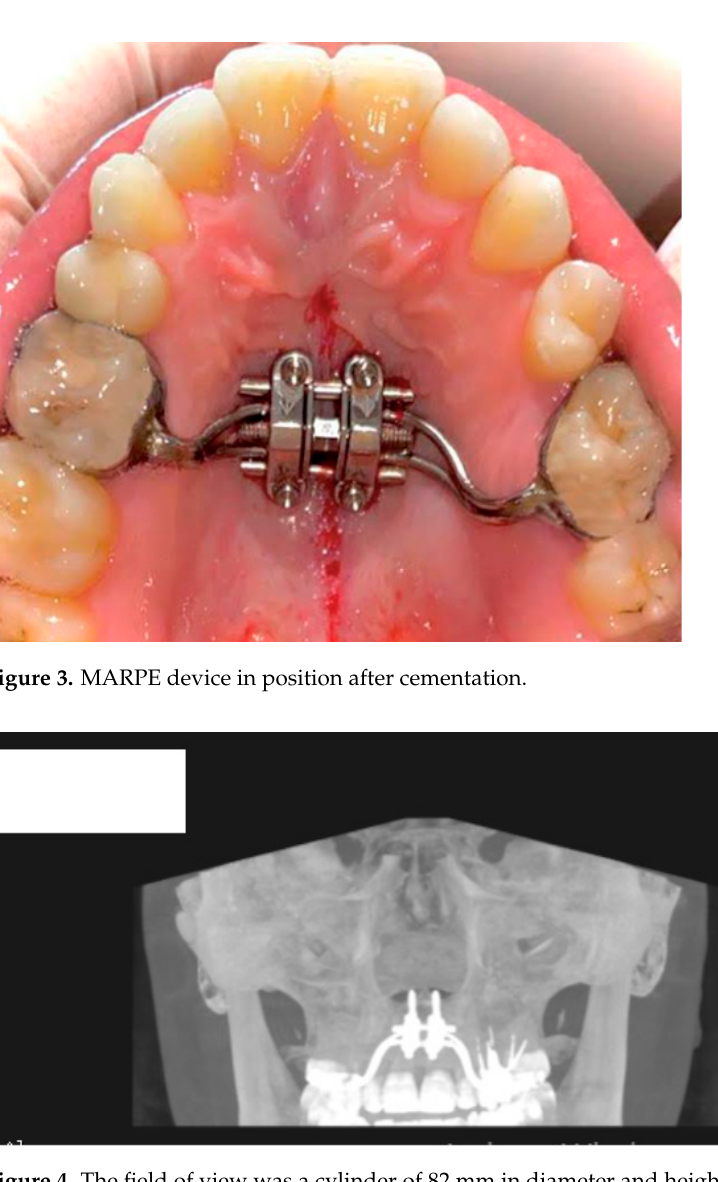
Figure 4. The field of view was a cylinder of 82 mm in diameter and height.